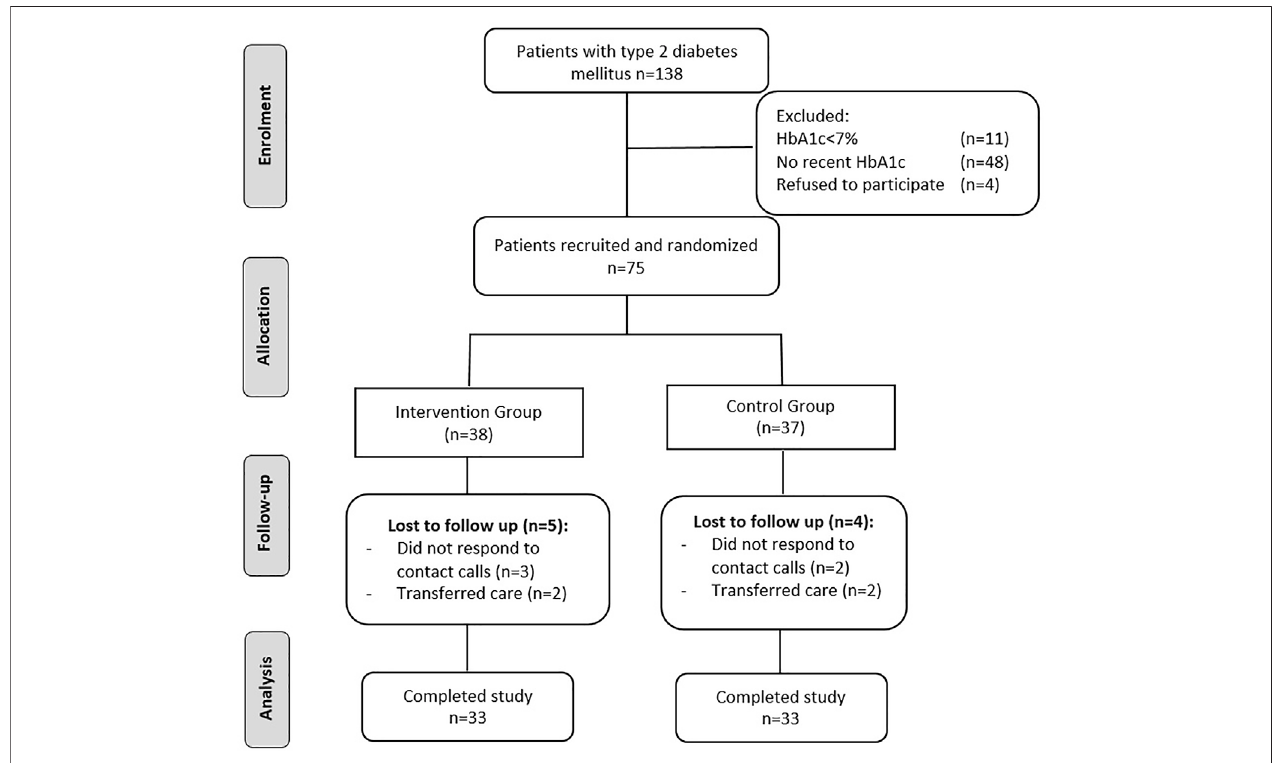
FIGURE 1 | Study fl ow diagram in accordance with CONSORT guidelines (CONSORT — Consolidated Standards of Reporting Trials).